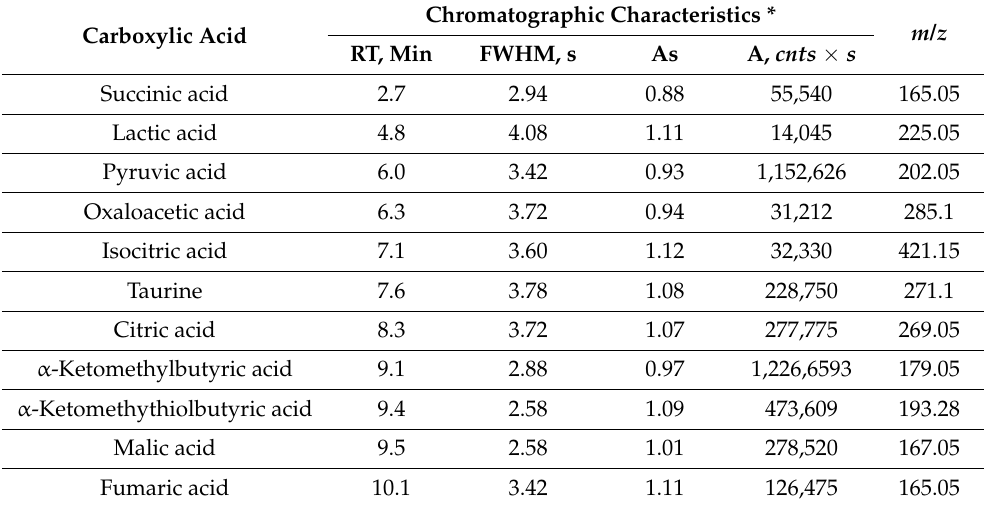
Table 8. Chromatographic characteristics of carboxylic acids detected as a result of triple quadrupole MS analysis. Carboxylic acids are presented in ascending order of retention time